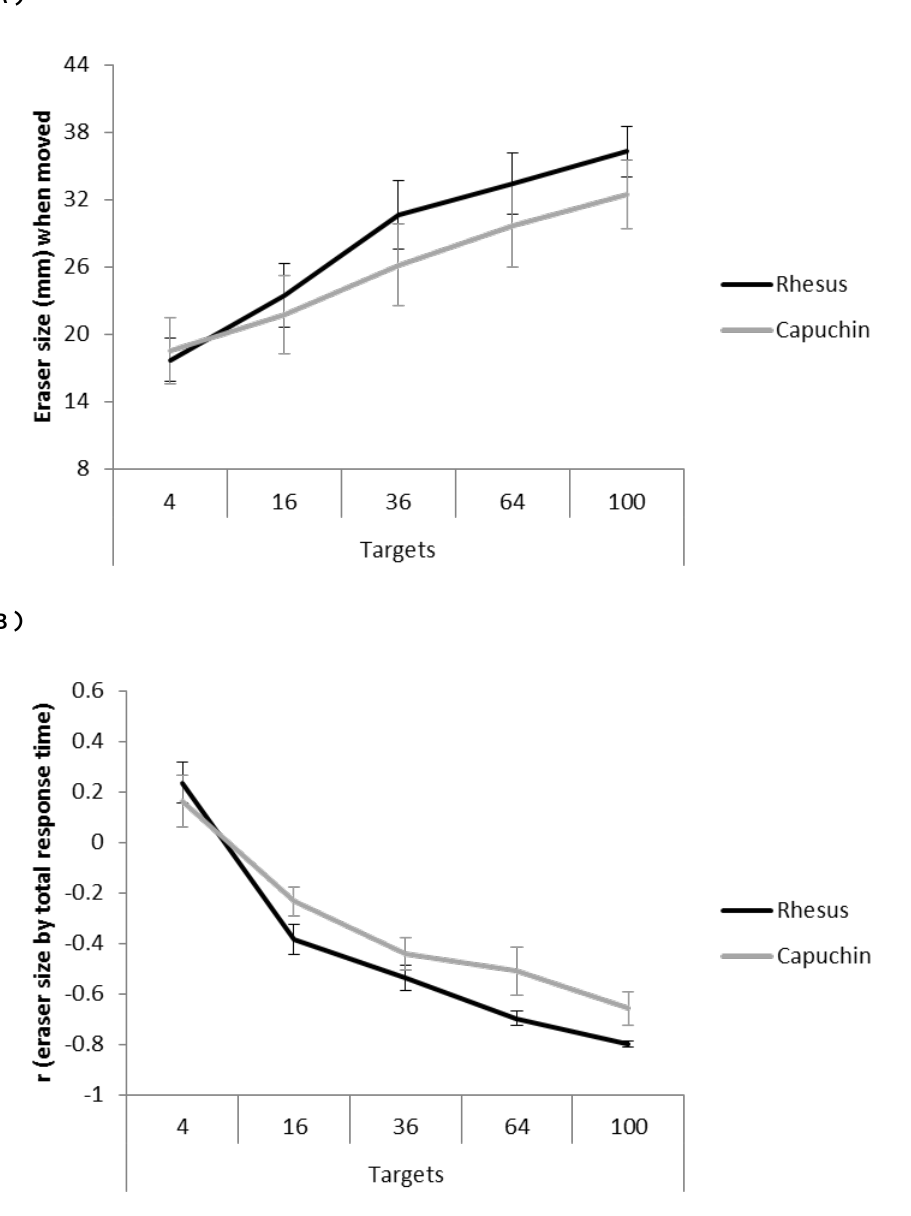
Figure 2 . Monkeys‟ performance in Testing Phase 1, as a function of target array size (x-axis) and species (separate lines). Panel (A) illustrates the mean size of the eraser before monkeys attempted to use it. Panel (B) shows the mean relationship (correlation coefficient) between final eraser size and total trial time. Note that all size values represent either the length or width of the stimulus (not the area). Error bars represent standard error of the